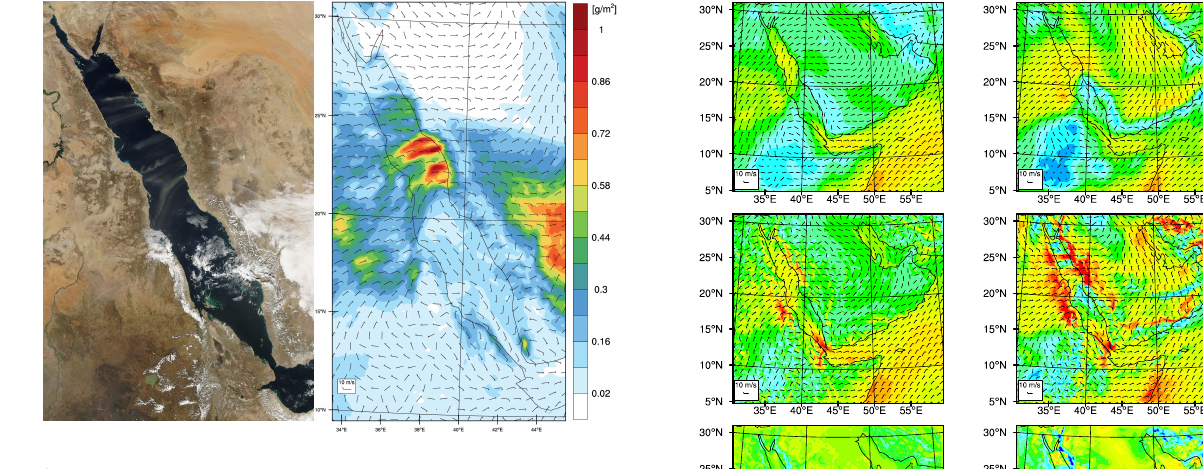
Fig. 1. An image taken by Aqua/MODIS over the Red Sea at 10:55 UTC on 14 January (left panel) and the WRF-Chem’s column inte- grated dust load [gm − 2 ] prediction and 10 m wind vector fields for 11:00UTC on 14 January (right panel).